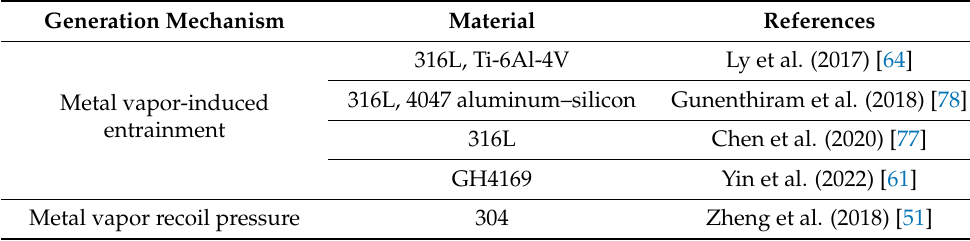
Table 5. A summary of the studies on spatter from solid substrate